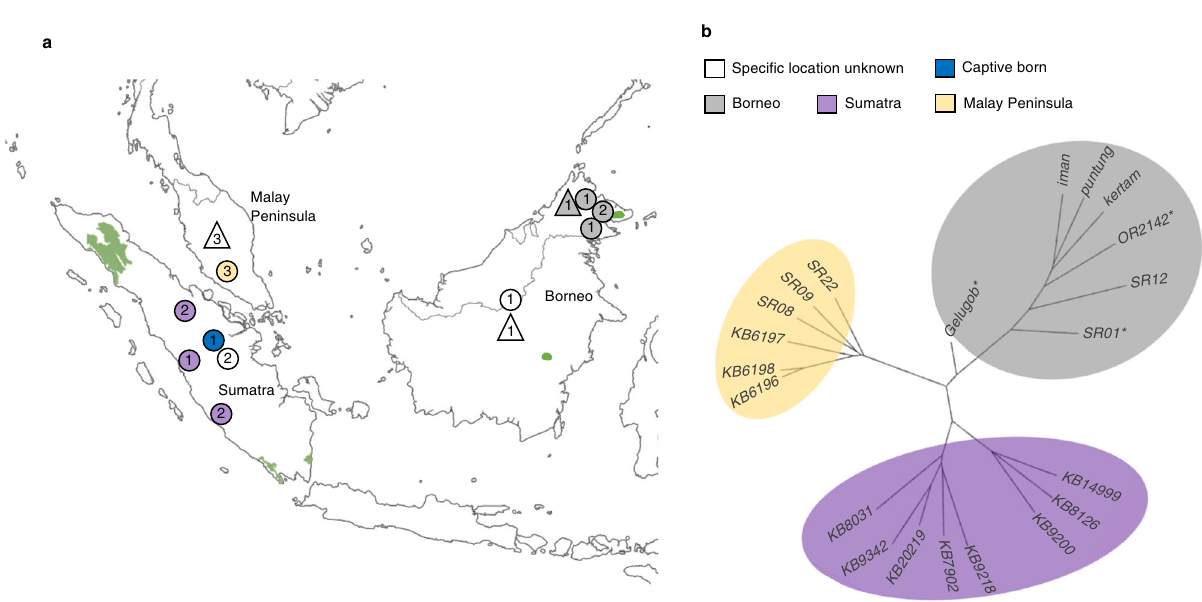
Fig. 1 Sampling, current range, and phylogeny for Sumatran rhinoceros ( Dicerorhinus sumatrensis ). a Geographical origin of the 21 Sumatran rhinoceros genomes analysed in this study. Current distribution is depicted in green 40 . Triangles and circles represent approximate geographical sampling locations of historical and modern samples, respectively. The numbers within the geometric symbols depict the number of samples from the corresponding location. b Unrooted phylogeny (100 bootstrap replicates). Asterisks denote low coverage (< 9X) genomes.